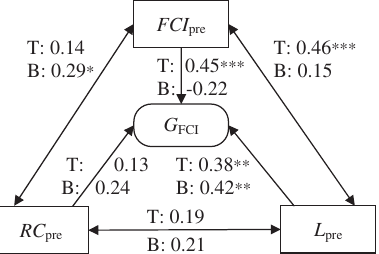
FIG. 9. Spearman’s rank correlation between single student normalized FCI gain ( G FCI ) and the three pretest variables: representational consistency on the R-FCI ( RC pre ), the FCI score ( FCI pre ), and the Lawson score ( L pre ). Students were placed into the top ( T , n ¼ 69 ) or bottom ( B , n ¼ 62 ) half according to their RC pre . (cid:5) p < 0 : 05 , (cid:5)(cid:5) p < 0 : 01 , (cid:5)(cid:5)(cid:5) p < 0 : 001